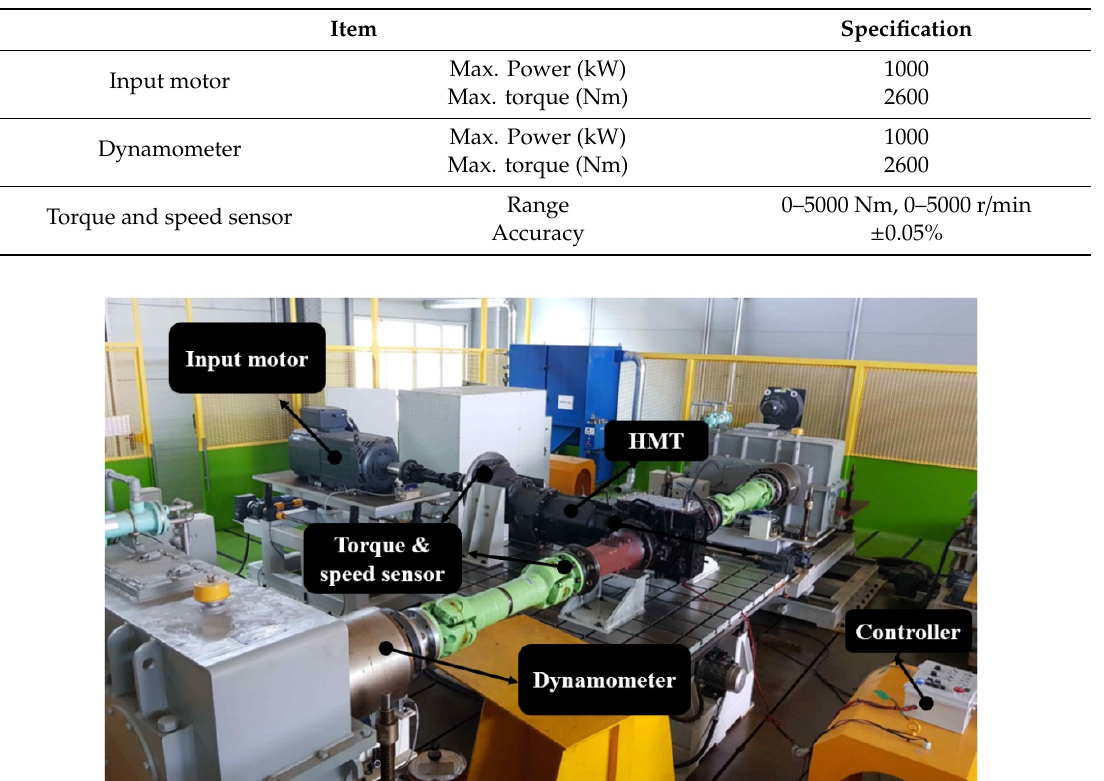
Figure 5. Diagram of the test bench for the performance evaluation of the HMT such as axle torque and rotational speed, power transmission efficiency. Table 2. Specifications of the test bench.